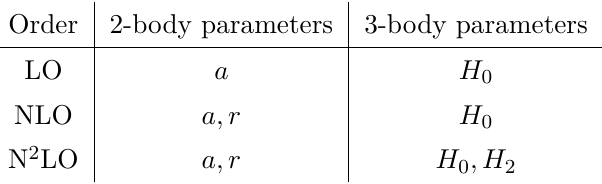
Table 1 . The parameters, appearing at different